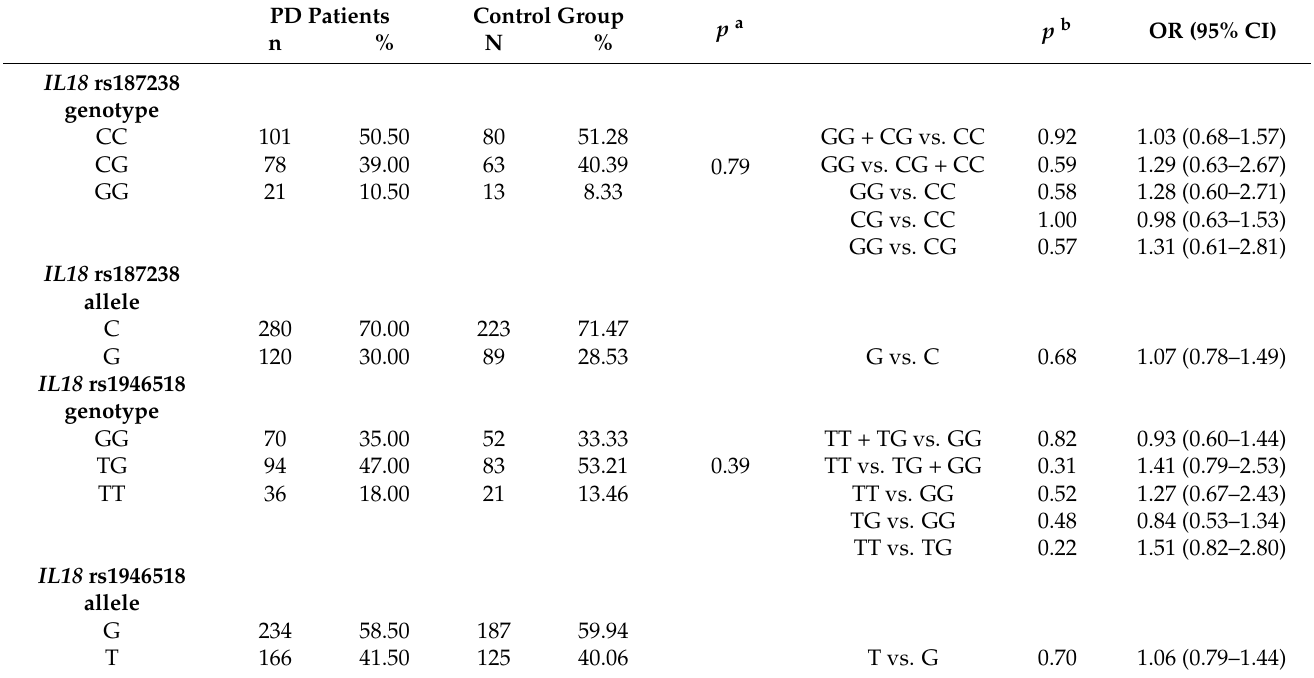
Table 2. The distribution of the IL-18 rs187238 and rs1946518 genotypes in periodontitis patients (PD patients) and the control group.